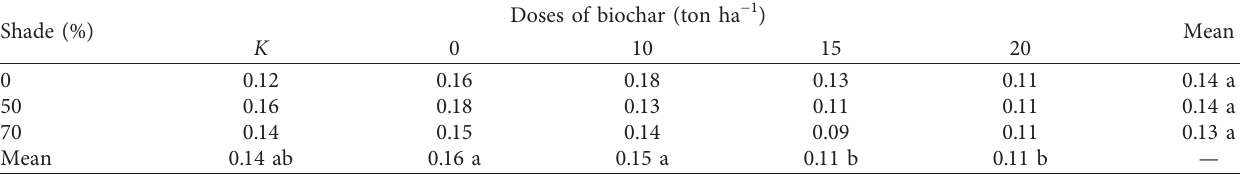
Table 11: Effects of biochar and shade application on total nitrogen content (%).